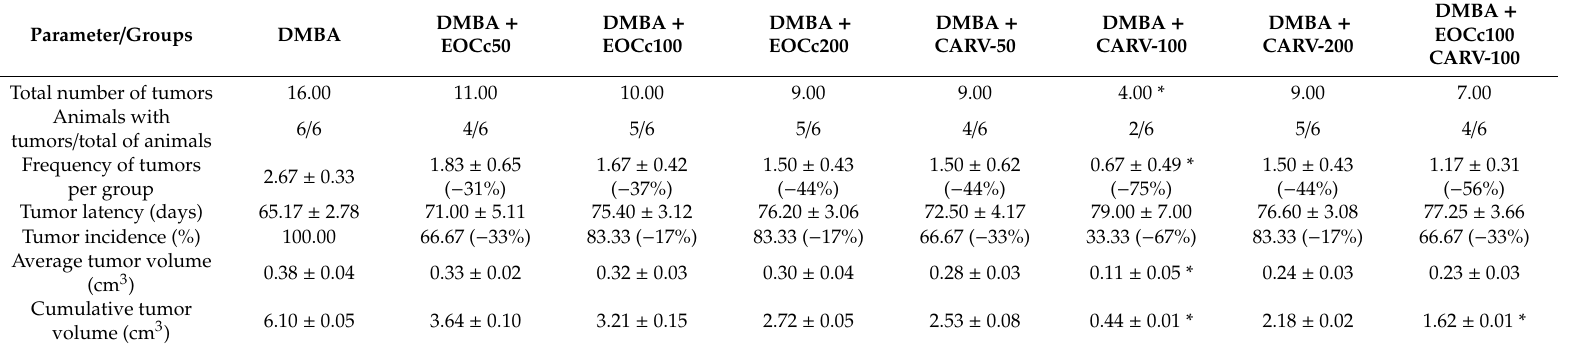
Table 2. E ff ect of the essential oil of C. citratus and carvacrol on DMBA induced breast carcinogenesis in